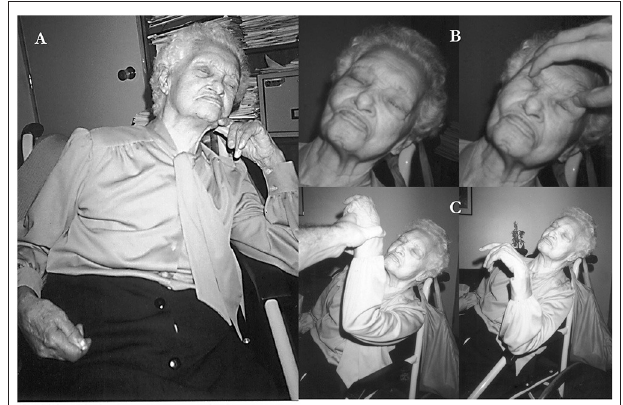
FIGURE 1 | Persistent catatonic features of patient. (A) This spontaneously adopted attitude could remain unchanged for hours on end (catalepsy). (B) Active opposition to passive elevation of the lids (active negativism). (C) Sustained attitude of the left arm which was passively imposed by examiner (waxy